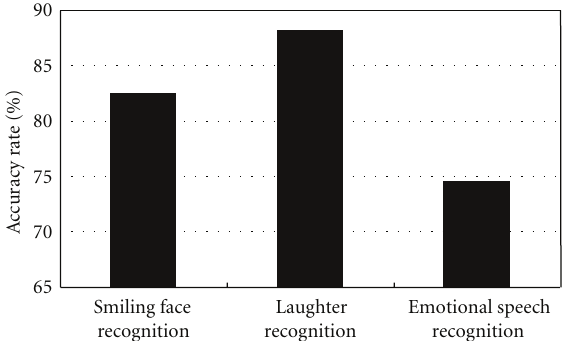
Figure 5: Accuracy rates of the audiovisual recognition.